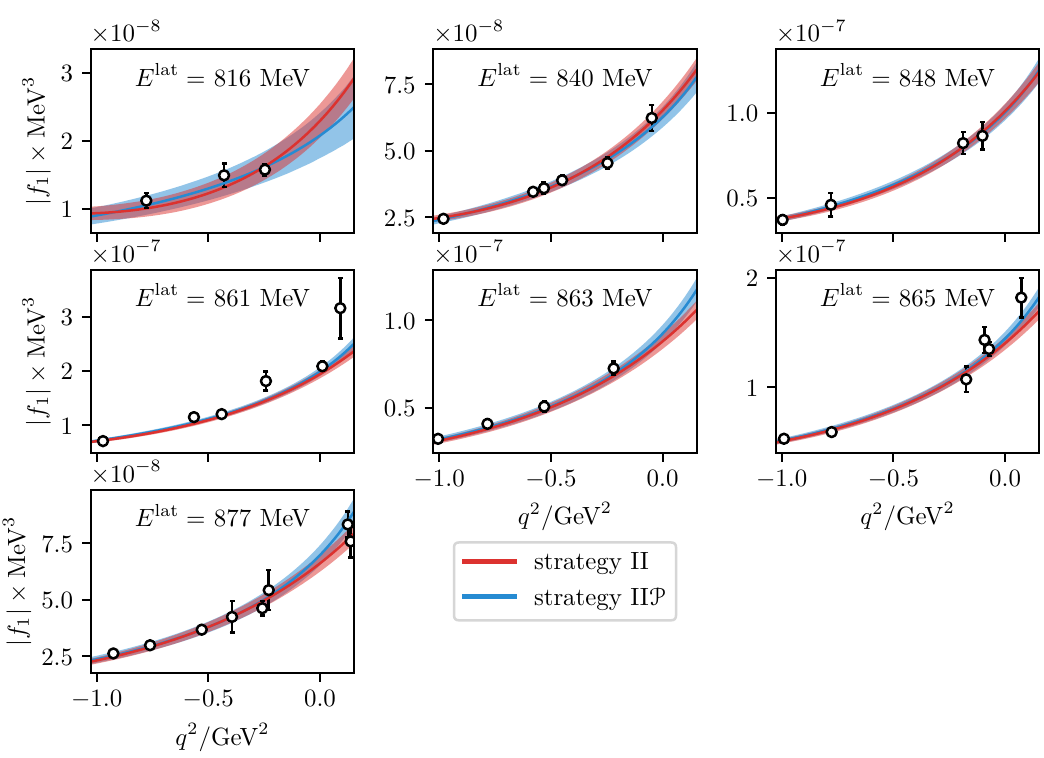
Figure 3. As figure 2, but for the lattice data of refs. [16, 17] at M π ≈ 391 MeV .